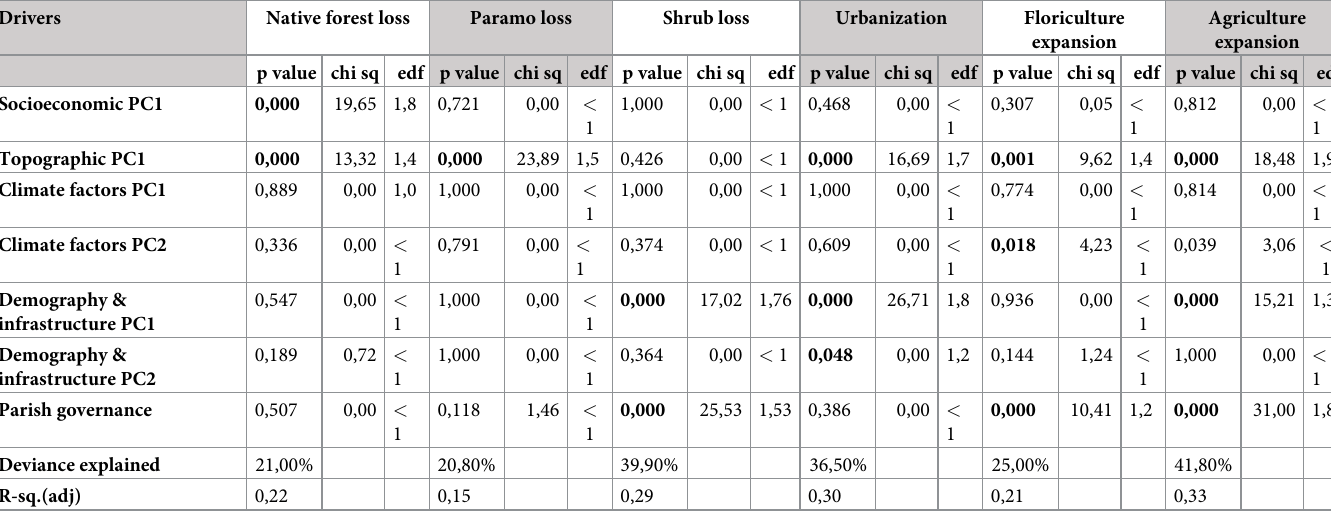
Table 3. Summary of the results of the generalized additive models to elucidate drivers of change for the six LULC transition models in Pedro Moncayo county.